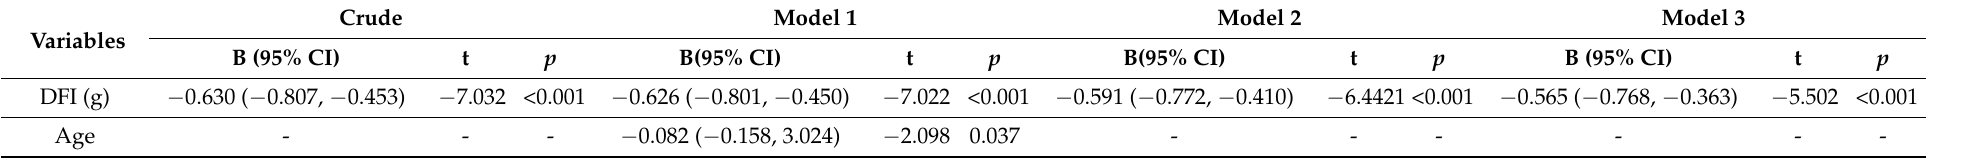
Table 5. Regression analysis summary for the score of anxiety.